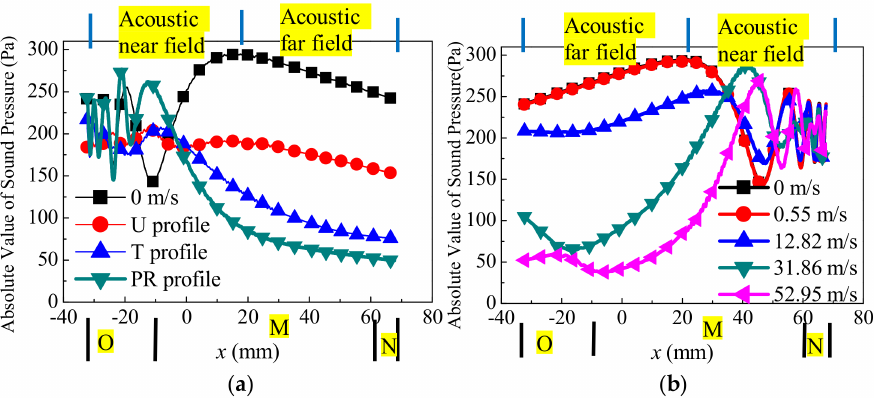
Figure 13. Propagation features of the acoustic beam on the central line of the acoustic path. ( a ) Downstream propagation ( v = 31.86 m/s, different velocity profile). ( b ) Upstream propagation (different flow velocity, PR